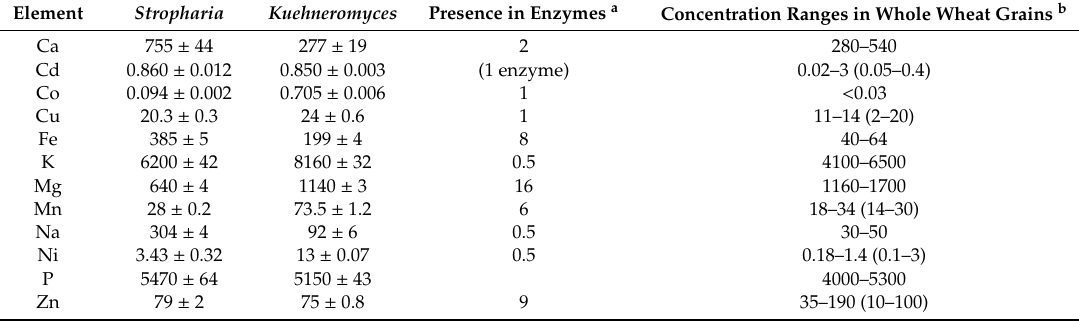
Table 3. Out-regulated concentrations (mg kg − 1 ± SD by dry weight (DW)) of essential, enzyme-asssociated minerals in unwashed basidiospores of S. rugoso-annulata and K. mutabilis in comparison to those in wheat grains ( n = 2).